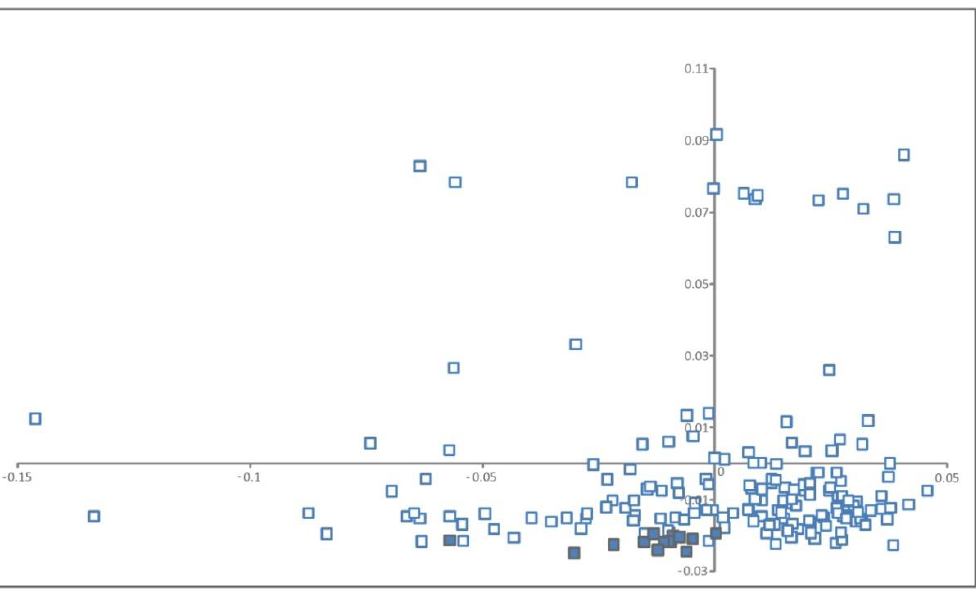
Figure 1. Dispersion of the individual Djallonké sheep genotypes on the bidimensional space formed by the two first factors retained after computation of principal component analysis (PCA) on the between individuals distance matrix. Factor 1, on the X-axis explained 14.5% of the variance. Factor 2, on the Y-axis, explained 4.7% of the variance. Individuals sampled in the surroundings of Mangodara are in open squares while those sampled in Dédougou are in solid squares.